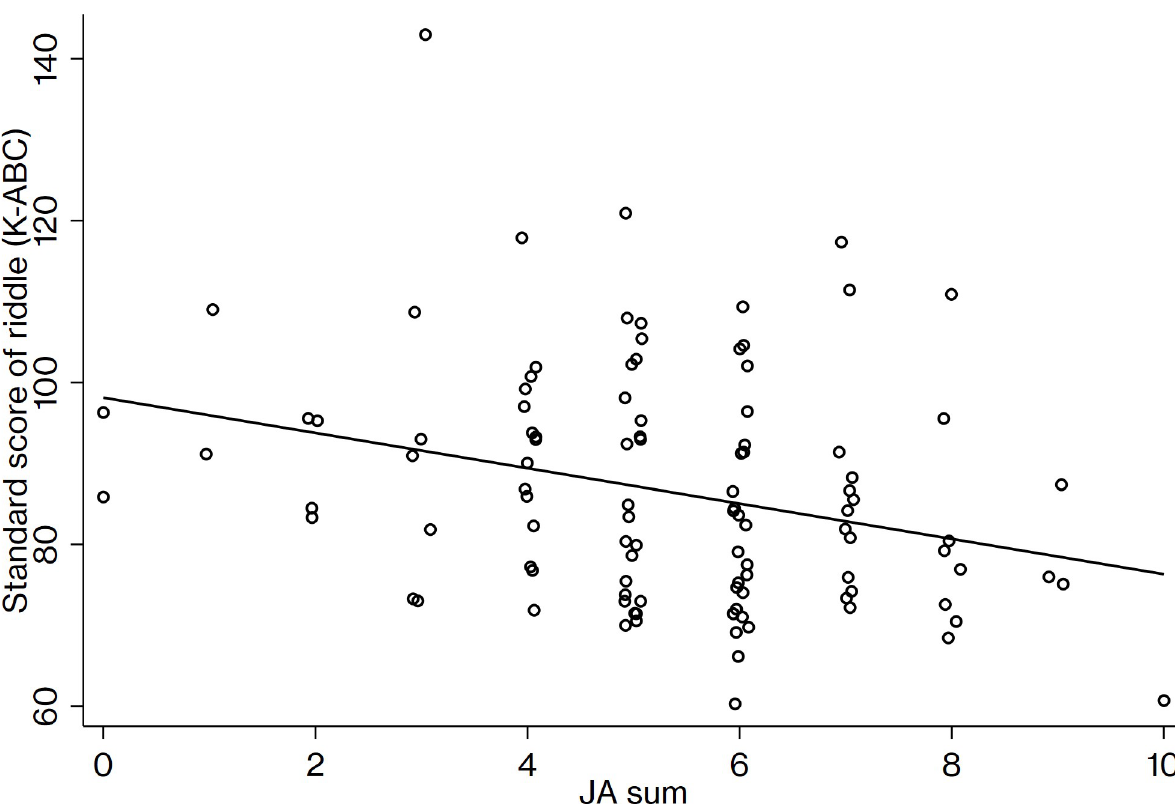
Fig 1. Relation between conceptual inference ability and Joint attention. Relation between conceptual inference (Riddle) on the Kaufman Assessment Battery for Children and ADOS-2 Joint Attention. JA sum, the total score of ADOS-2 Module 2 items, Pointing, Gesture, Unusual Eye contact, Showing, and Initiation of Joint